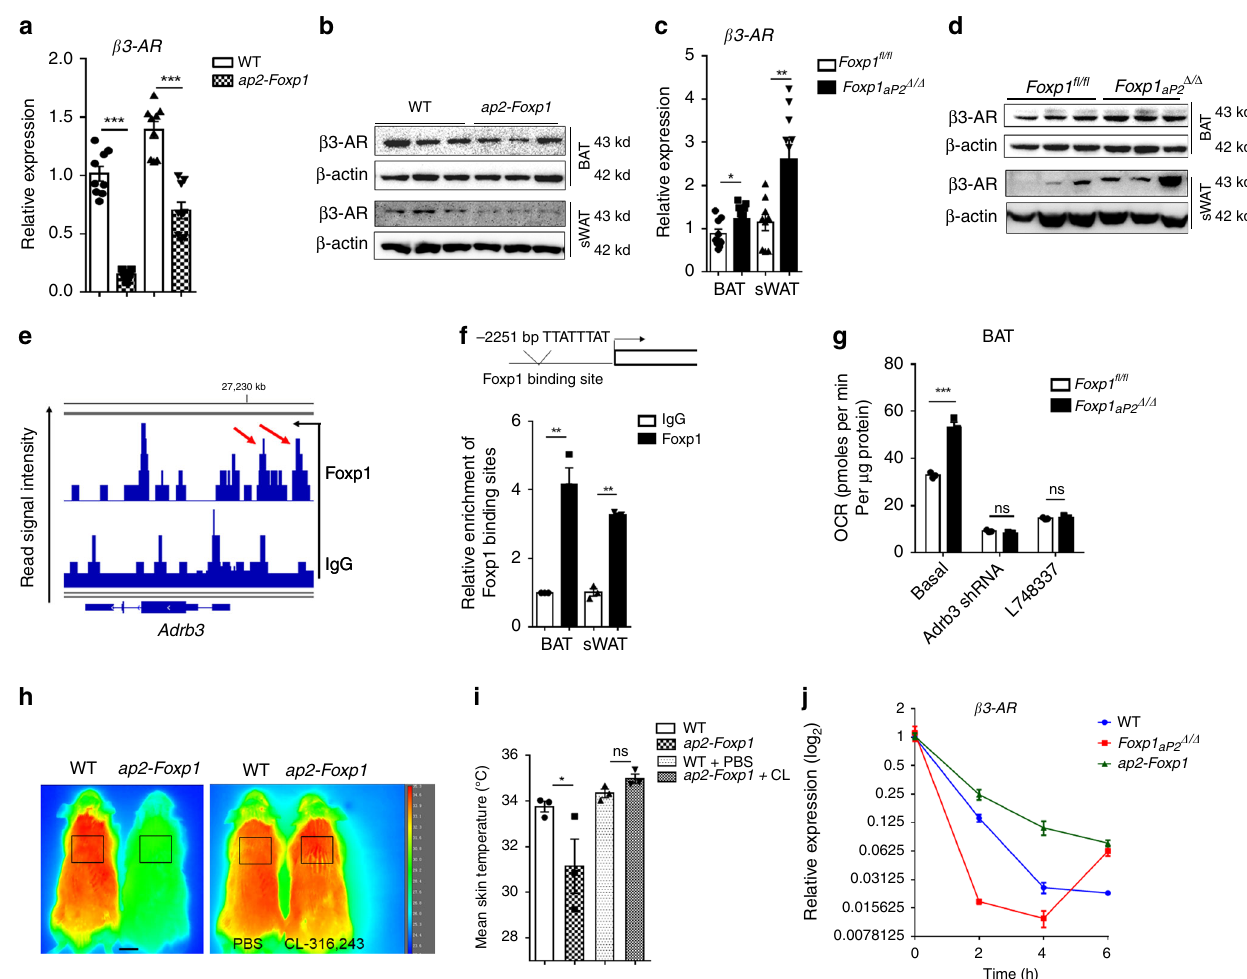
Fig. 5 Foxp1 represses β 3-AR transcription in adipocytes. a, b β 3-AR expression in BAT and sWAT were assessed by qPCR and western blotting in aP2- Foxp1 transgenic mice at 2 month old. n = 3 biologically independent samples/each group. c, d β 3-AR expression in BAT and sWAT were assessed by qPCR and western blotting in Foxp1 aP2 Δ / Δ knockout mice at 2 months old. n = 3 biologically independent samples/each group. e ChIP-seq pro fi le showed the Foxp1 binding sites within Adrb3 gene promoter region. Red arrows indicated the potential Foxp1 binding sites. Adrb3 gene was reversely transcribed. ChIP was based on SVF cells derived from BAT. f Upper panel showed the location of Foxp1 binding site at − 2251bp upstream of β 3-AR gene promoter with a schematic drawing. ChIP-PCR con fi rmed the relative enrichment of Foxp1 binding sites (lower panel). n = 3 biologically independent samples/each group. g Basic OCR of SVF-derived brown adipocytes from Foxp1 aP2 Δ / Δ mice, which were transfected β 3-AR -shRNA lentivirus or administrated with β 3-AR inhibitor L748337 (10 μ M) for 1 h. n = 3 biologically independent experiments. h Representative infrared imaging of aP2-Foxp1 transgenic mice with or without 6-hour CL-316,243 (10 μ M) exposure. Bar, 1 cm. i Quanti fi cation of average skin temperature in boxed regions in ( h ). n = 4 biologically independent mice/each group. Samples were isolated from mice at age of 2 months. j CL-stimulated β 3-AR desensitization in SVF-derived brown adipocytes from aP2-Foxp1 transgenic mice and Foxp1 aP2 Δ / Δ knockout mice. β 3-AR expression was assessed by qPCR during the 6-h time course of CL-316243 (0.1 μ M) treatment. n = 3 biologically independent samples/each group. * P < 0.05; ** P < 0.01; *** P < 0.001; error bar, mean ±